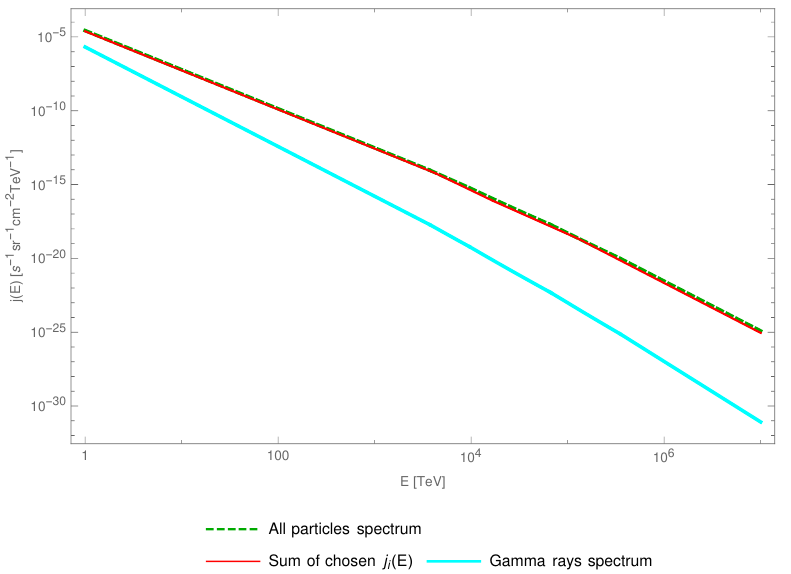
Figure 12. Parameterised energy spectra of all cosmic-ray nuclei [19] (dashed line), sum of energy spectra of five representative nuclei used in this work (orange line) and the energy spectrum of gamma rays